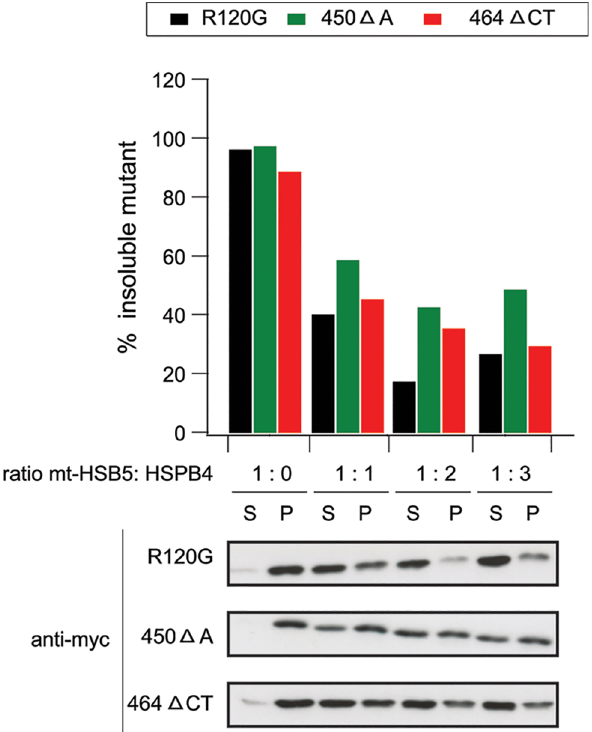
Fig 5. HSPB4 prevents the aggregation of HSPB5 mutants in C2C12 myoblasts. Mouse myoblast C2C12 cells were co-transfected with myc-HSPB5 mutants (R120G, 450 Δ A, 464 Δ CT) and FRTTO as a control (1:0 ratio) or HSPB4-V5 (at increasing ratios 1:1, 1:2, 1:3). 48 h after transfection, cells were lysed in Triton X-100 and fractionated into Soluble (S) and Pellet (P) and western blot was performed. The percentage of insoluble HSPB5 mutants in each case was quantified ([p] density * 100 / ([p] density + [s] density )) and is depicted in the chart above the blot.